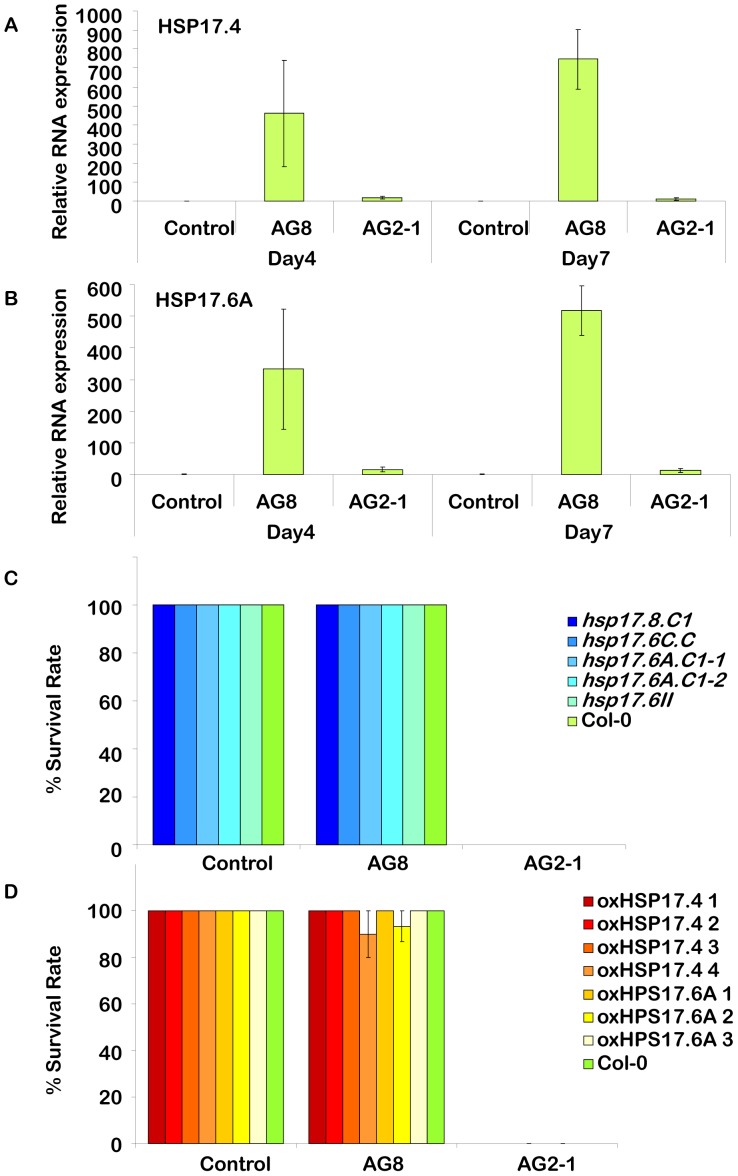
Analysis of the role of HSPs in the response to R. solani.Quantitative real time PCR of the genes A. HSP17.4 and B. HSP17.6A. Three biological replicates and two technical repeats were analysed at each time point (four and seven day after infecting 1 week old seedling) and treatment (non-infected control, AG8 and AG2-1). The average of each time point and treatment is presented with standard error bars. Cyclophilin was used as the reference gene to normalize expression. Day 4 (control) is standardized to equal one and all other treatments and timepoints reflect their fold induction compared to this point. Survival rate of C. loss of function and D. gain of function. Arabidopsis lines. Col-0 and the homozygous SALK lines, hsp17.8.C1 (SALK_059920C– At1g07400), hsp17.6C.C1 (SALK_056782C – AT1g53540), hsp17.6A.C1-1 (SALK_152961C – At59860), hsp17.6A.C1-2 (SALK_056925C – At59860) and hsp17.6II (SALK_043928C - At5g12020) were tested for survivorship against non-infected control, R. solani AG8 and AG2-1. Four independent lines overexpressing HSP17.4 (oxHSP17.4 lines 1–4), and three independent lines overexpressing HSP17.6 (oxHSP17.6 lines 1–3) were tested for survivorship against non-infected control, R. solani AG8 and AG2-1.